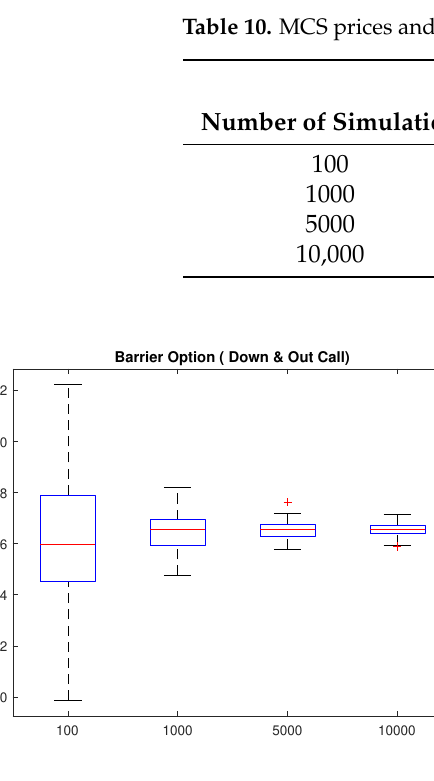
Figure 9. Bootstrapping for Barrier options: the down-and-out call ( left ) and the up-and-out put ( right